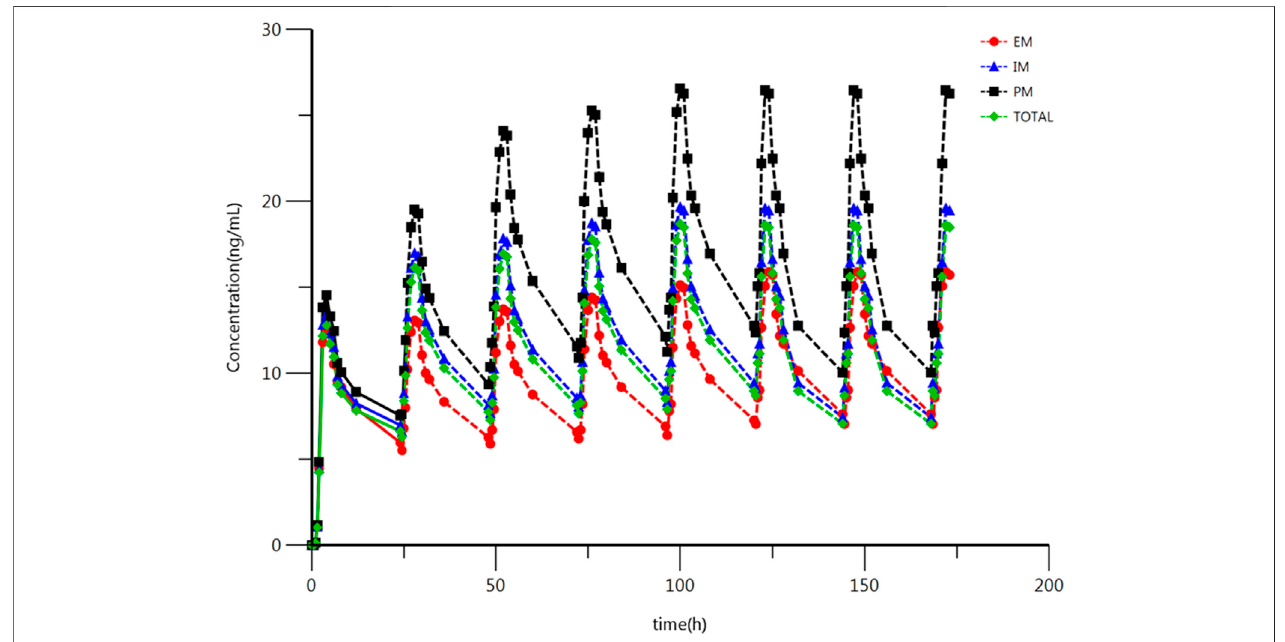
FIGURE3| Plasmaconcentration-timeschematicdiagramofescitalopramafteroral(multidose)administrationof10 mgescitalopramtabletintheIM,PMandEM. Based on the original concentration data and the prediction of C ss . All values are presented as mean ± standard deviation.